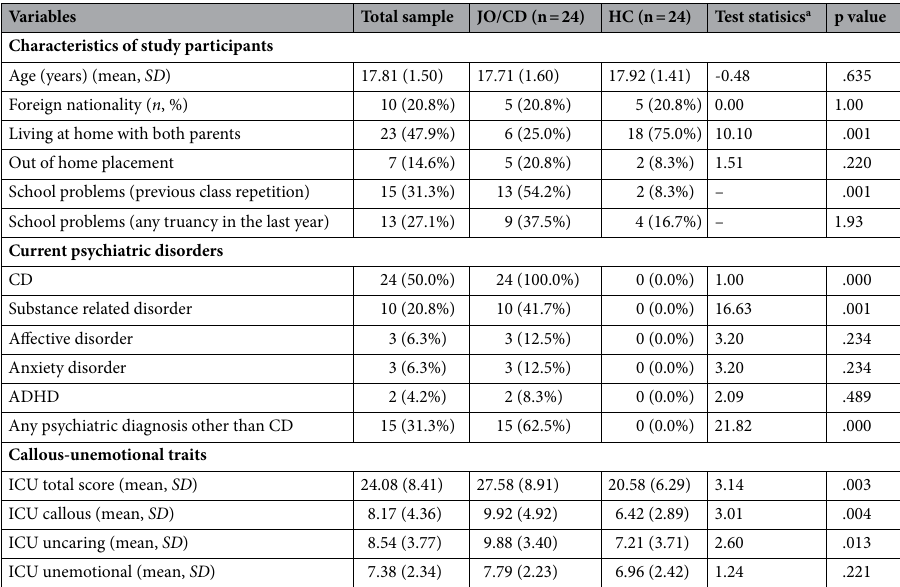
Table 1. Characteristics of study participants (at baseline), current psychiatric disorders, and callous unemotional traits of the total sample (N = 48), the JO/CD subsample (n = 24), and the HC subsample (n = 24). Note : JO/CD = male juveniles who committed serious violent offenses and met criteria of conduct disorder, HC = Healthy controls, SD = standard deviation, CD = Conduct disorder, ADHD = Attention-Deficit- Hyperactivity-Disorder, ICU = Inventory of Callous-Unemotional Traits, a t-test or χ 2 -test/Fishers’s exact test.